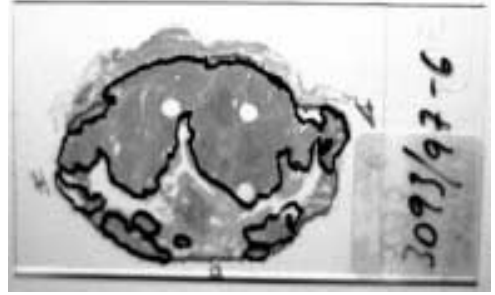
Fig. 1. A wholemount slice of a prostate, including landmarks.